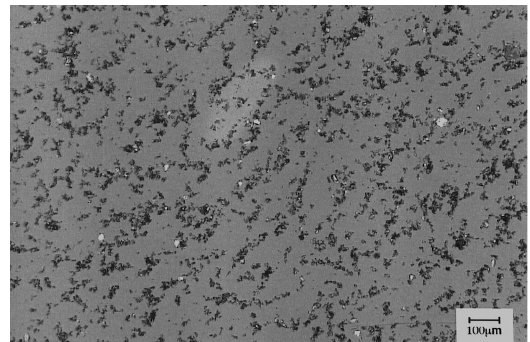
Sugar aggregates in